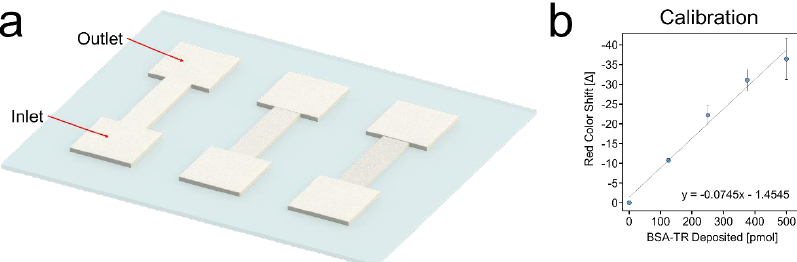
Figure A4. Protein transport test channels. ( a ) Each test strip had a 7 × 7 mm square inlet that lead to a 3 × 10 mm channel etched at either 0%, 50%, or 100%. In each inlet, 20 μL of either 50 or 100 μM BSA-TR was deposited and allowed to wick to the outlet. After 30 min, the red channel intensity of each outlet was compared to a blank to determine the red color shift and its corresponding BSA-TR concentration. ( b ) Calibration curve created from 7 × 7 mm squares deposited with a known quantity of BSA-TR. Data presented as mean ± SD. n = 3.